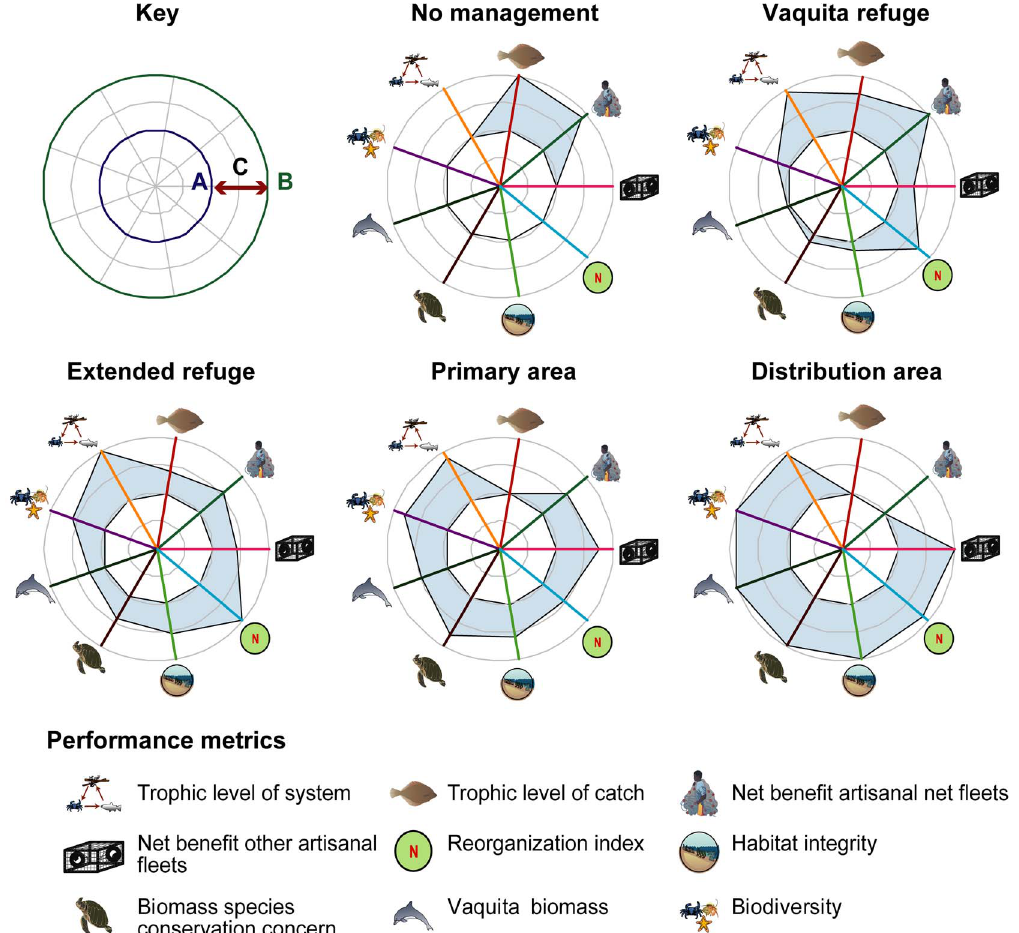
Figure 6. Performance of selected metrics across management scenarios. Since the metrics are not directly comparable (in absolute or relative change), we have scaled the performance metrics between the worst result observed (A/blue circle) and the best result observed (B/green circle); the range in between (C) shows the scope of possible outcomes. Symbols courtesy of IAN/UMCES Symbol and Image Libraries.